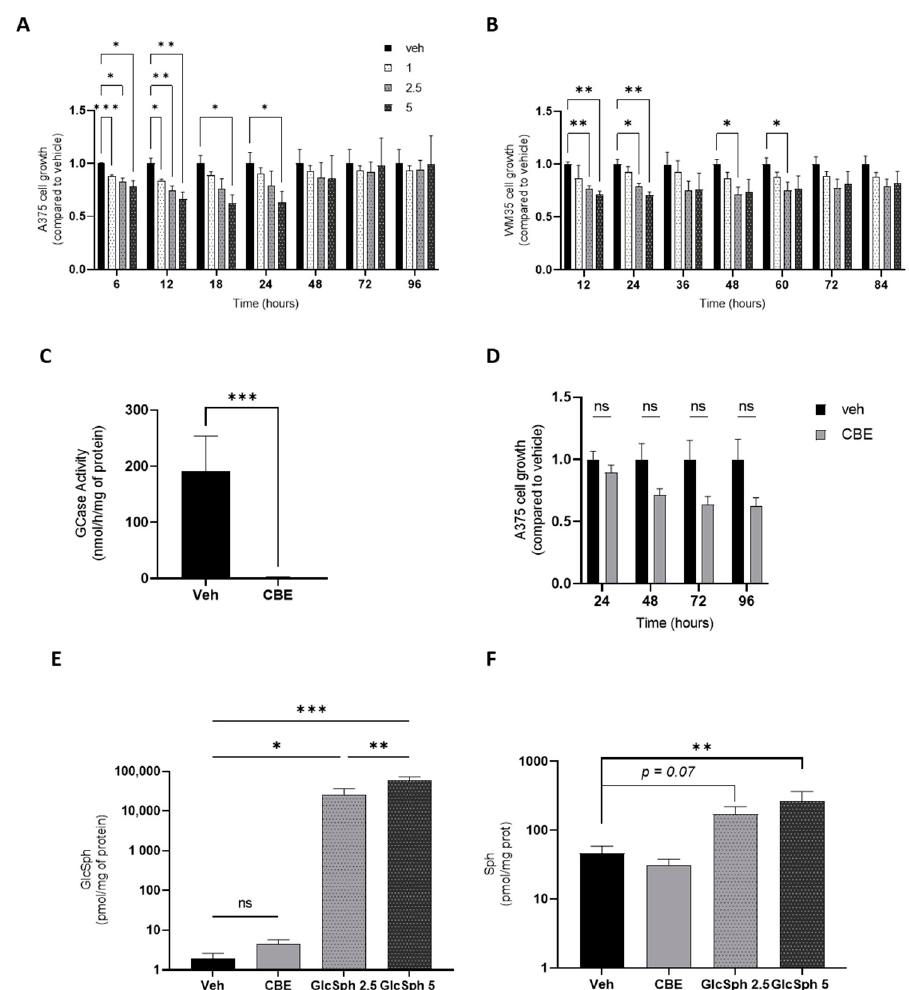
Figure 3. GlcSph decreases the growth of cultured human melanoma cells in a dose-dependent manner. ( A , B ) A375 and WM35 human melanoma cells were seeded into a 96-well plate (10,000 cells/well) and, 24 h later, treated either with different concentrations of GlcSph (1, 2.5, or 5 µM) or with ethanol (veh). Cell growth was assessed by measuring the cellular confluence using an IncuCyte S3 time-lapse microscopy system. For each sample, the cellular confluence was measured in duplicate at different incubation times for 4 days. ( C ) GCase enzyme activity in A375 cells treated with CBE (30 µM) or DMSO (veh) for 48 h. ( D ) A375 cells were seeded into a 96-well plate and, after 24 h, treated either with CBE (30 µM) or DMSO (veh). Cell growth was evaluated as described in ( A , B ). GlcSph ( E ) and Sph ( F ) were extracted as described in [13] , and concentrations were determined by liquid chromatography-tandem mass spectrometry in CBE- or GlcSph-treated cells compared to controls. For all experiments, data are expressed as means +/ − SEM of three independent experiments. Statistical significance was determined by a two-way mixed ANOVA with Geisser–Greenhouse correction ( A , B , D ) or a Mann–Whitney test ( C,E,F ). *, p < 0.05; **, p < 0.01; ***, p < 0.001; ns, not significant compared to vehicle-treated